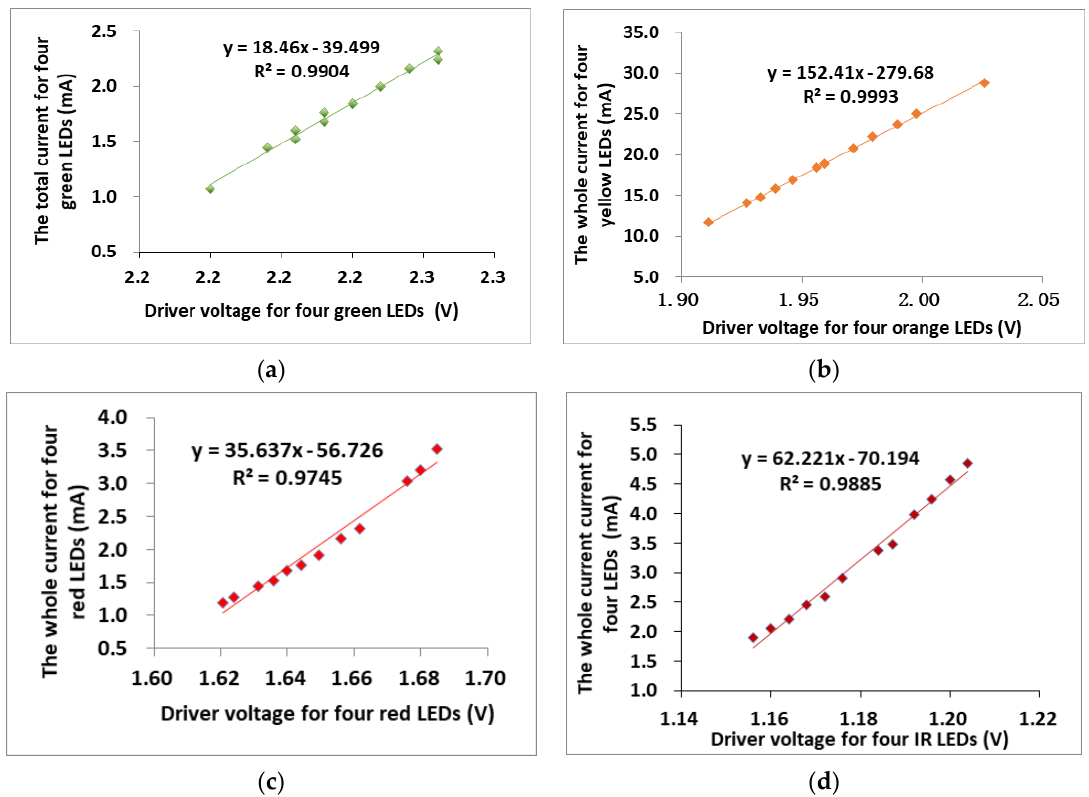
Figure 7. Linear approximations of the relationship between the current supplied to the LEDs and voltage supplied by the MCU. The relationship between the current supplied to the LEDs and voltage supplied by the MCU for the green LEDs (525 nm), orange LEDs (590 nm), red LEDs (650 nm) and infrared LEDs (870 nm): ( a ) green LEDs; ( b ) orange LEDs; ( c ) red LEDs; and ( d ) IR LEDs.